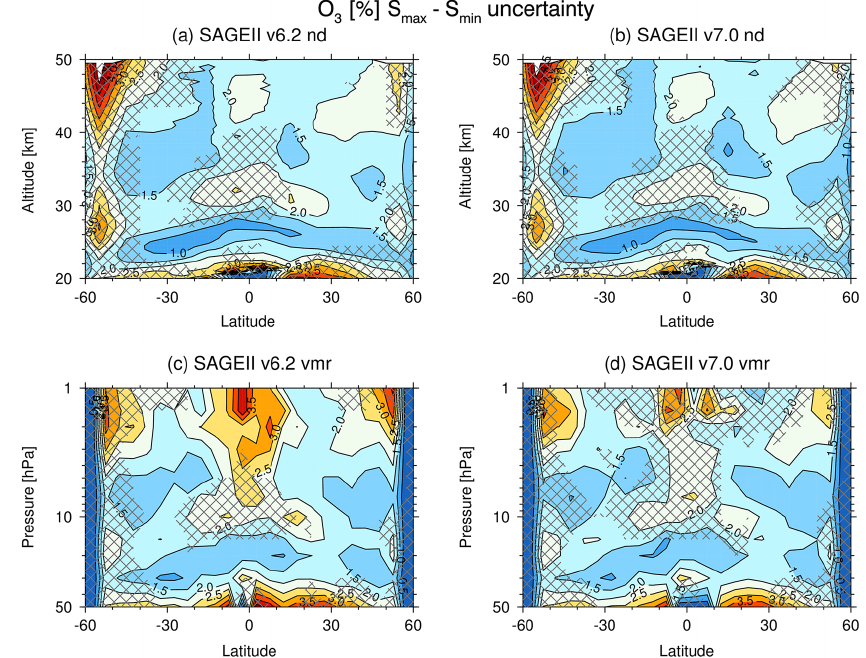
Figure 5. The 95% confidence intervals (CI) on the SORs (SOR ± CI) shown in Fig. 4 for the (a, c) SAGE II v6.2 data and (b, d) SAGE II v7.0 data in terms of (a, b) number-density–altitude coordinates and (c, d) volume-mixing-ratio–pressure coordinates. The contour interval is 0.5%. The hatching is as in Fig.